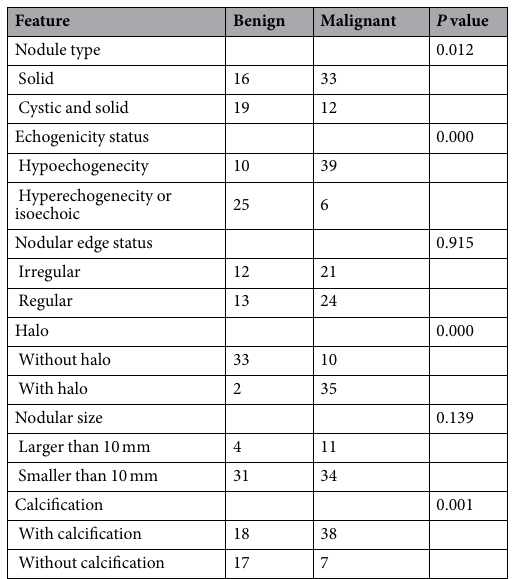
Table 2. The ultrasonographic features of Bethesda category I nodules.